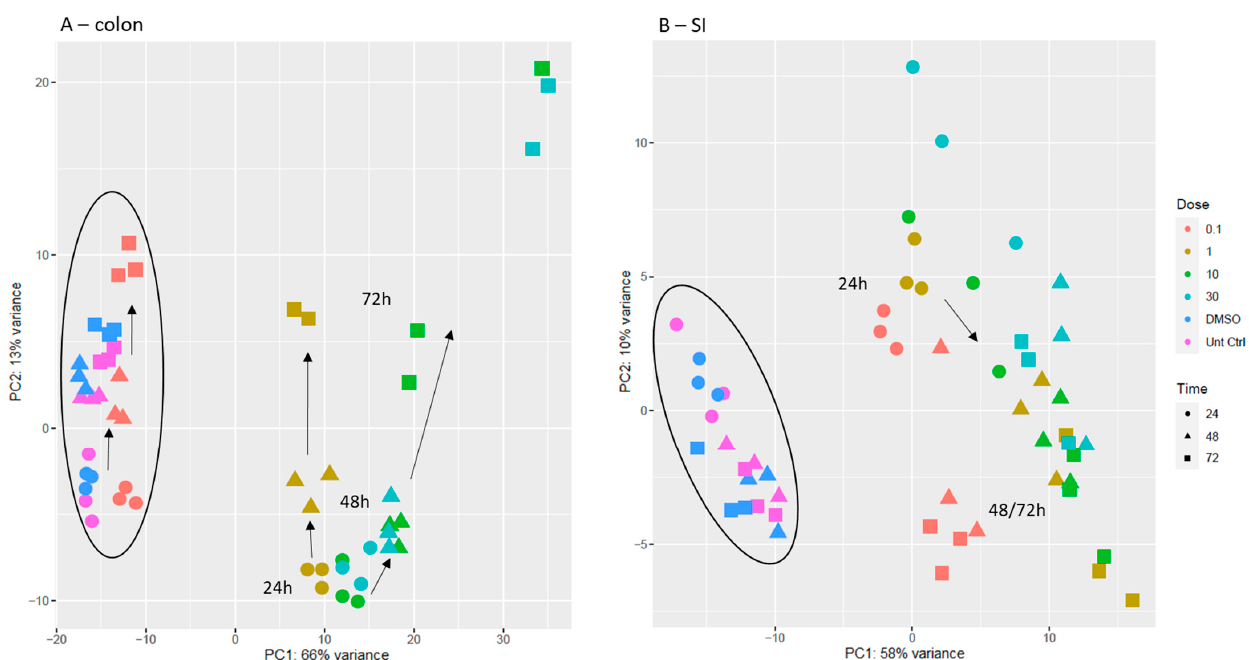
Figure 5. PCA score scatter plot obtained for the mRNA transcriptomic analysis of samples collected from colon organoids ( A ) and SI organoids ( B ). Direction of the arrows indicates the evolution in time of the samples (24 h → 48 h → 72 h). In colon plot, cluster on the left comprises non-treated samples (untreated and vehicle controls); in SI plot, cluster on the left comprises non-treated samples and treated samples with 0.1 µM gefitinib. Legend: untreated controls are in pink; vehicle controls (DMSO) are in dark blue; 0.1 µM gefitinib in red; 1 µM gefitinib in dark yellow; 10 µM gefitinib in green; and 30 µM gefitinib in light blue. Circles represent 24 h; triangles, 48 h; squares, 72 h.